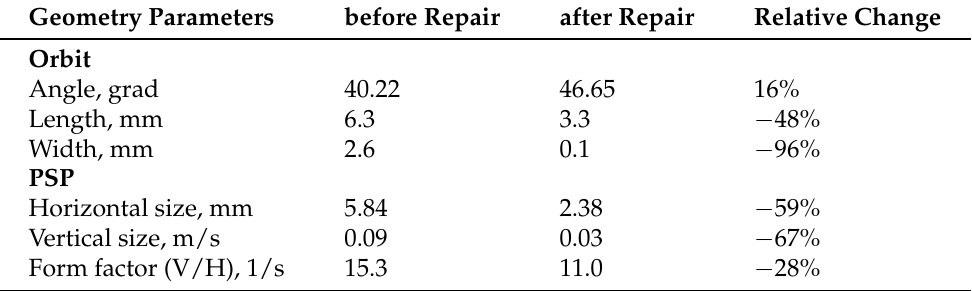
Table 2. Geometric parameters of orbit and PSP on the left side of the lower shaft (damaged bearing).